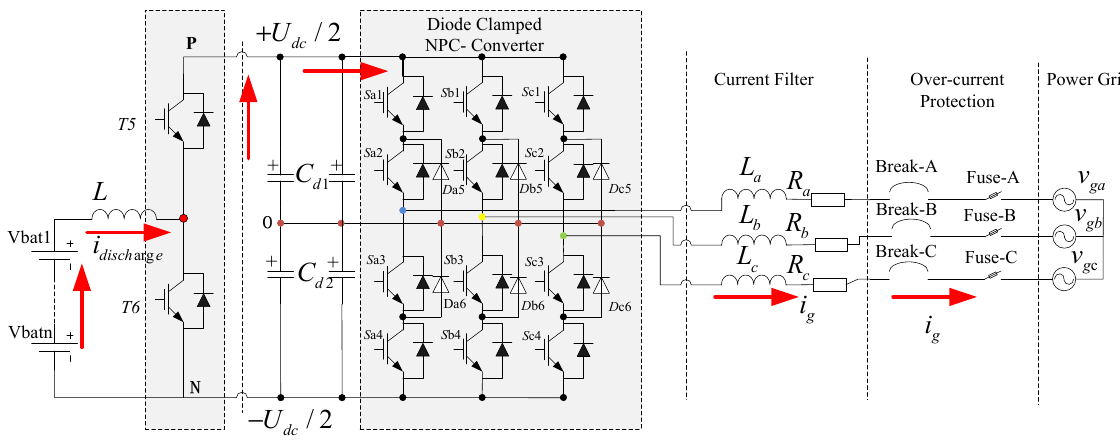
Figure 2. Power circuit topology of the ERLPABTS using the NPC-VSC